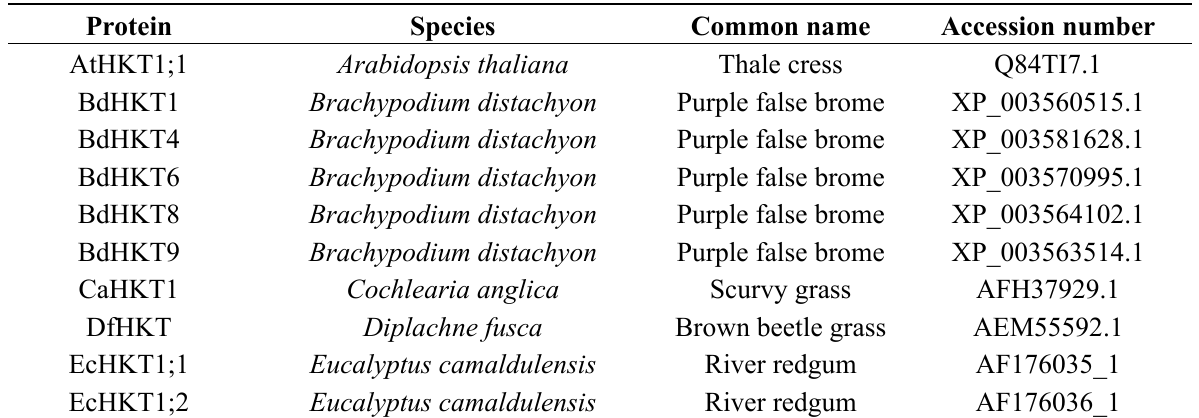
Table 1. List of entries used for phylogenetic analysis of plant High-affinity Potassium Transporters (HKTs) proteins ( cf . Figure 1). Accession numbers of protein sequences were obtained with the BLAST tool from the NCBI database to search for sequences that relate to the OsHKT1;5, EcHKT1;2 and AtHKT1;1